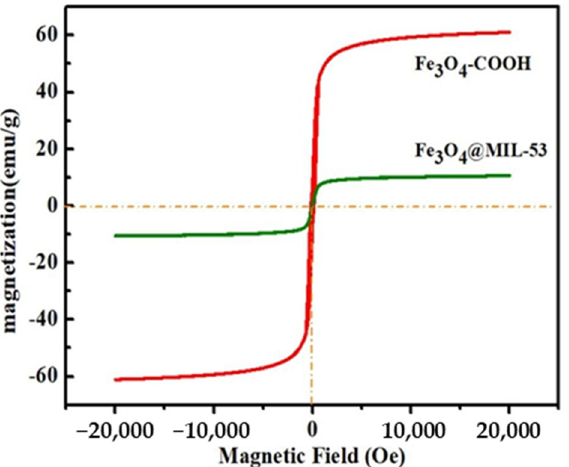
Figure 3. Vibrating sample magnetometry image of Fe 3 O 4 -COOH and Fe 3 O 4 @MIL-53(Al).